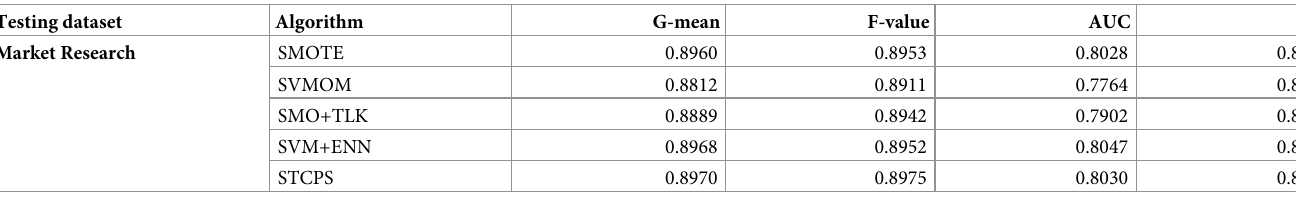
Table 5. Comparison of composite indicators of different